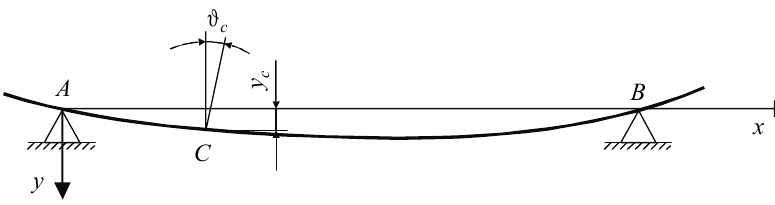
Figure 16. Deformation of the object supported by two vee-blocks and the linear and angular displacements resulting from this deformation.